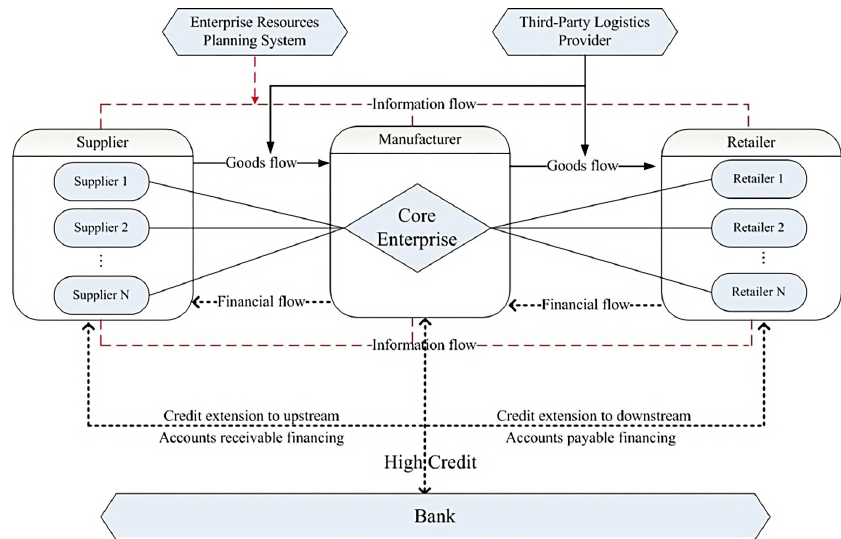
Fig. 2. The ecosystem of